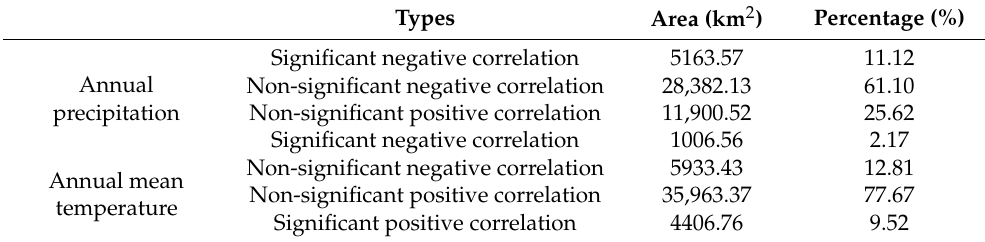
Table 4. Area and proportion of types associated with climate and